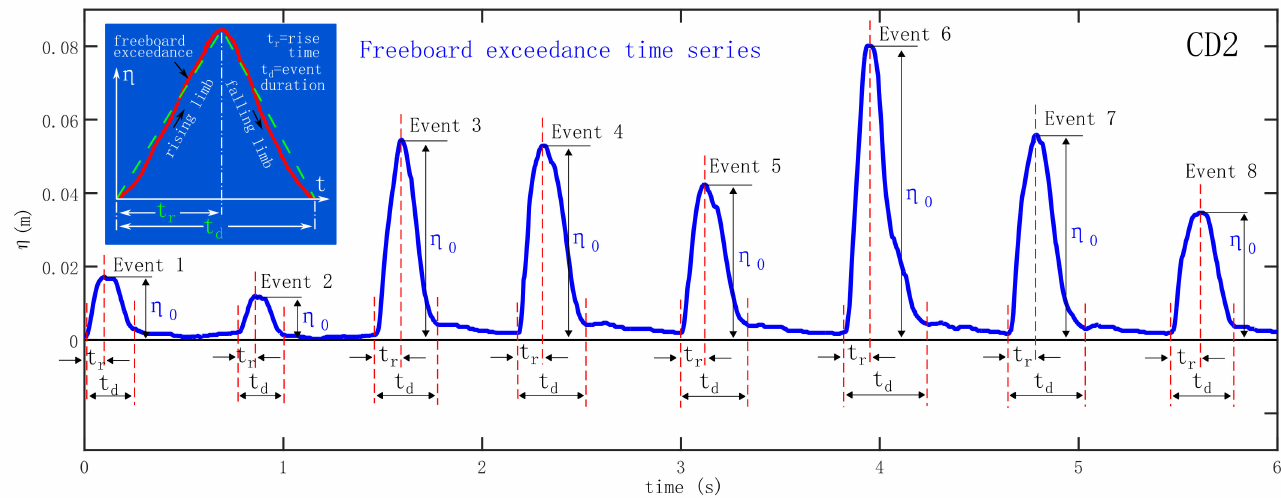
Figure 8. Time series of freeboard exceedance measured by probe d2 from the deck level at the start of the structure, for the eight green water events observed in